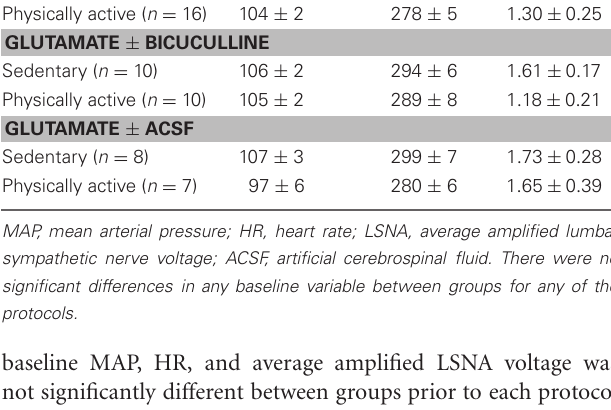
PROTOCOL #1—EFFECT OF INCREASING CONCENTRATIONS OF GLUTAMATE IN THE RVLM OF SEDENTARY VERSUS PHYSICALLY ACTIVE RATS